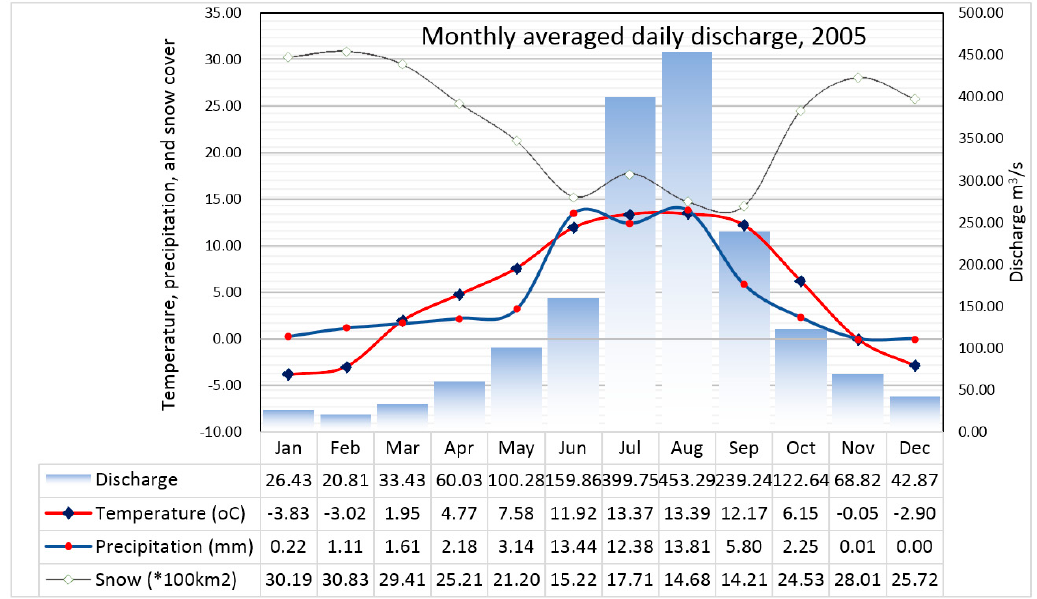
Figure 3. Comparison of monthly average river discharge at the outlet with average snow cover, temperature, precipitation in the Budhi Gandaki River Basin, 2005. Remote Sens. 2020 , 12 , x FOR PEER REVIEW